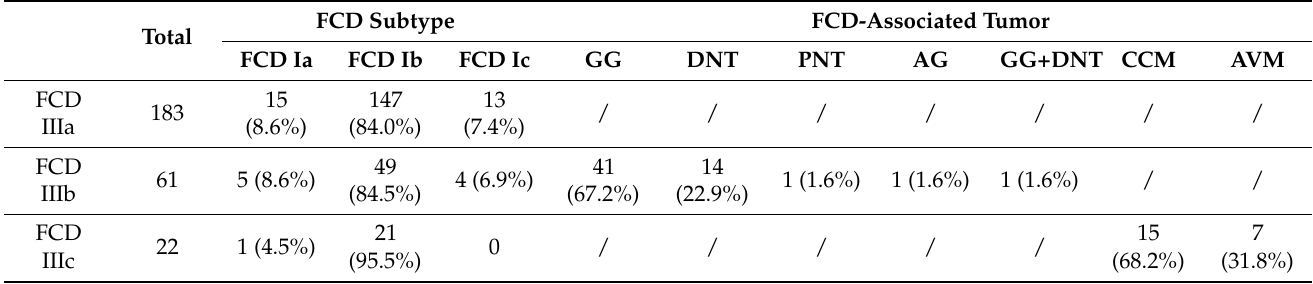
Table 2. Surgical pathology findings of 266 patients with FCD type